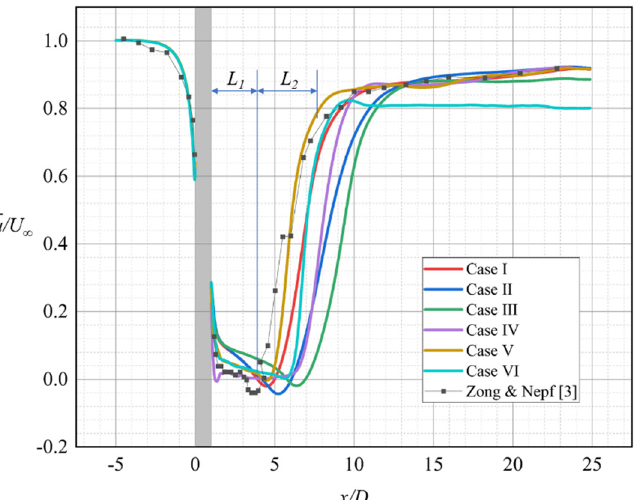
Figure 6. The longitudinal flow profiles simulated by six turbulence models are illustrated in comparison with the experimental results of Zong and Nepf ( Φ = 0.1, D = 22 cm) [3], where the longitudinal mean velocity ( u ) is measured at the centerline, y = 0. The gray part indicates the internal area of vegetation patches.